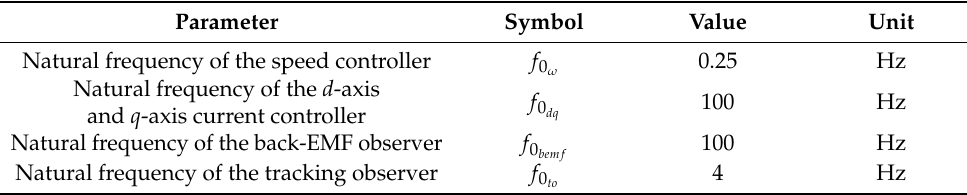
Table A4. Parameters for the Sensorless FOC with Luenberger-type back-EMF